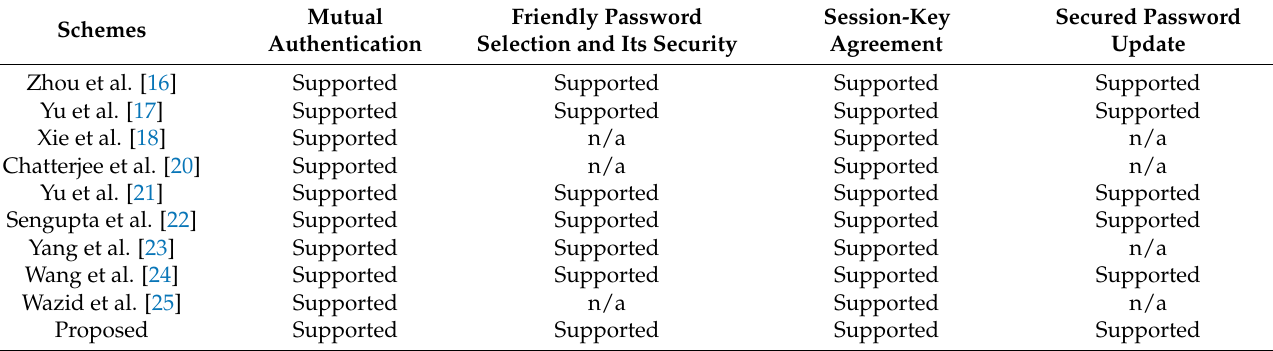
Table 5. Comparison of functional